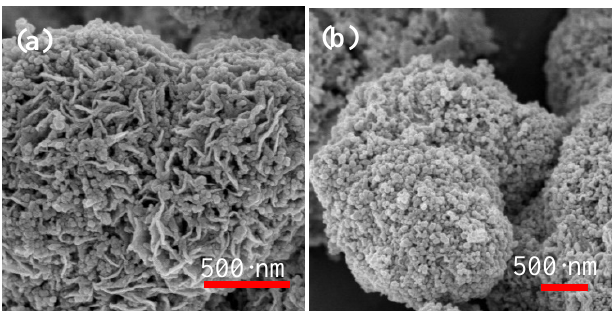
Figure 11. ( a ) SEM of S3 composite material without aging and ( b ) aged for 20 days.